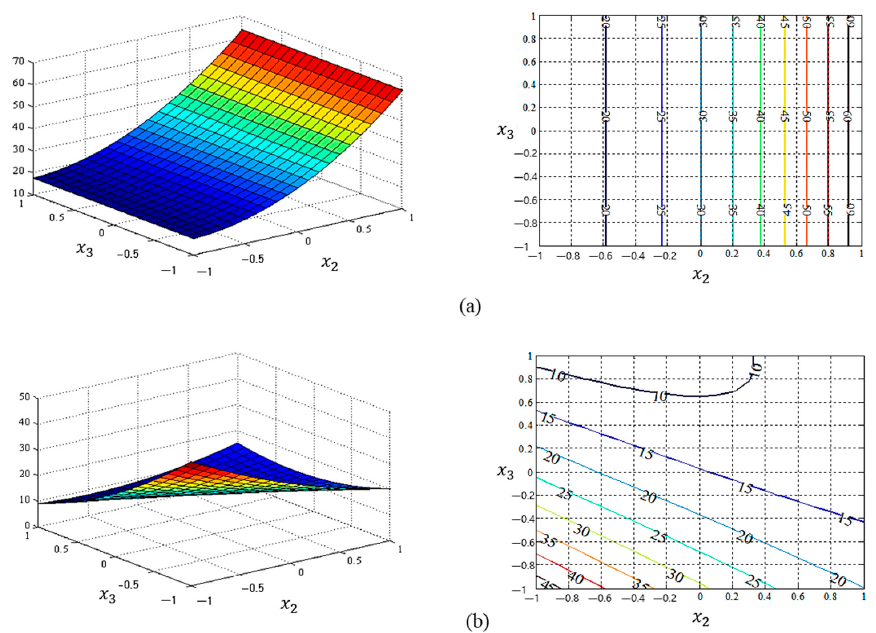
Figure A4. Graphical representation of the estimated standard deviation response functions between x 2 and x 3 : ( a ) the response surface plot and response function of LSM; ( b ) the response surface plot and response function of NN.